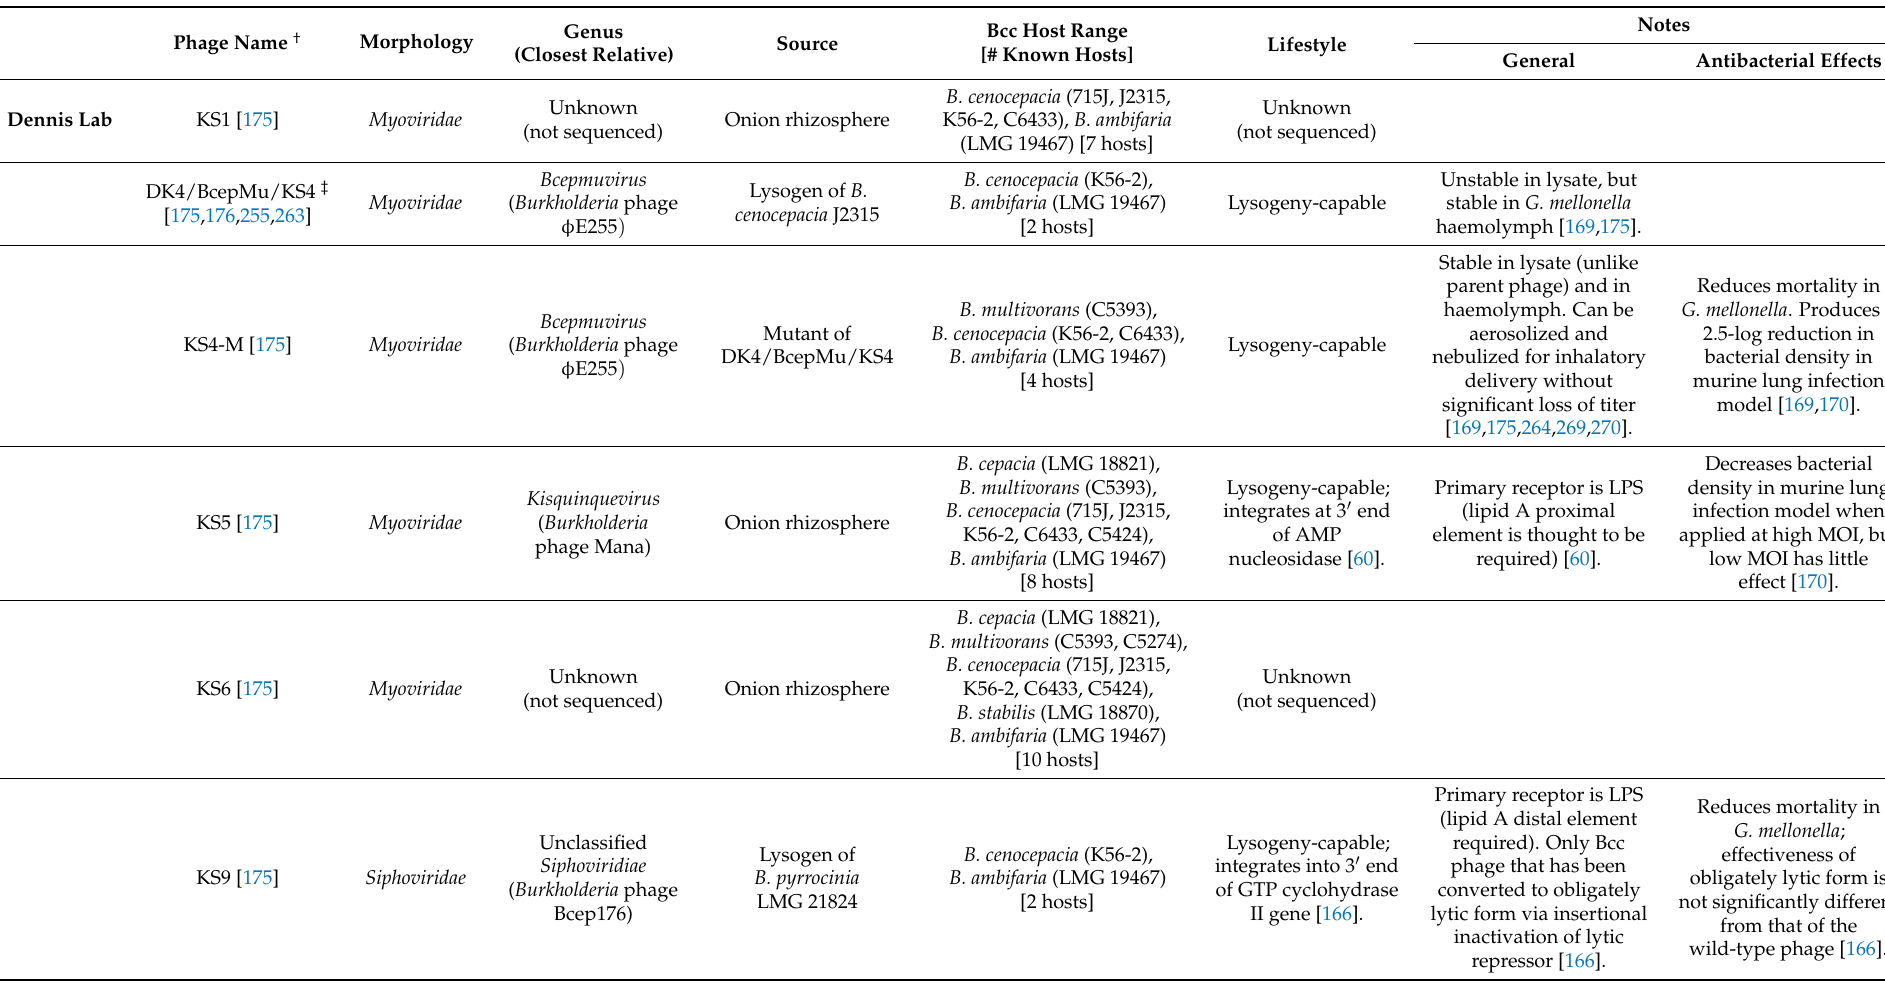
Table 1. Phages of the Burkholderia cepacia complex (Bcc)